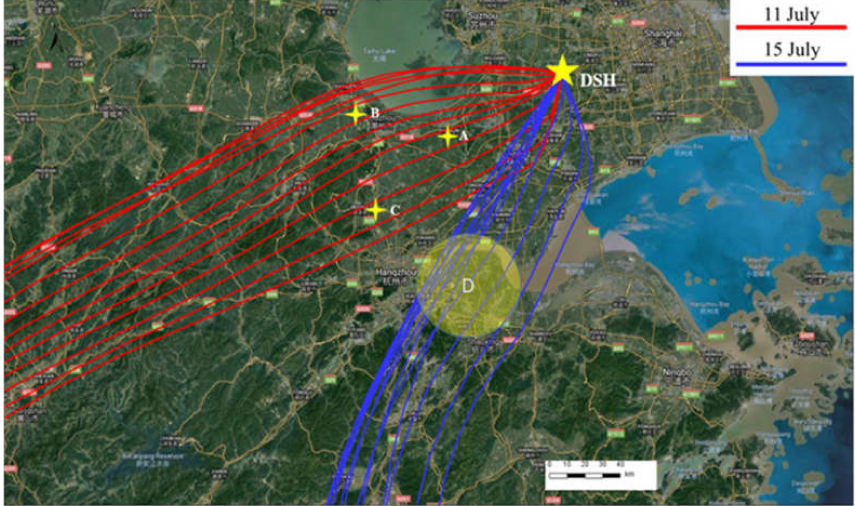
Figure 12. Backward trajectories at the DSH site from 7:00 a.m.–7:00 p.m.1 on 11 July (red lines) and 15 July (blue lines)